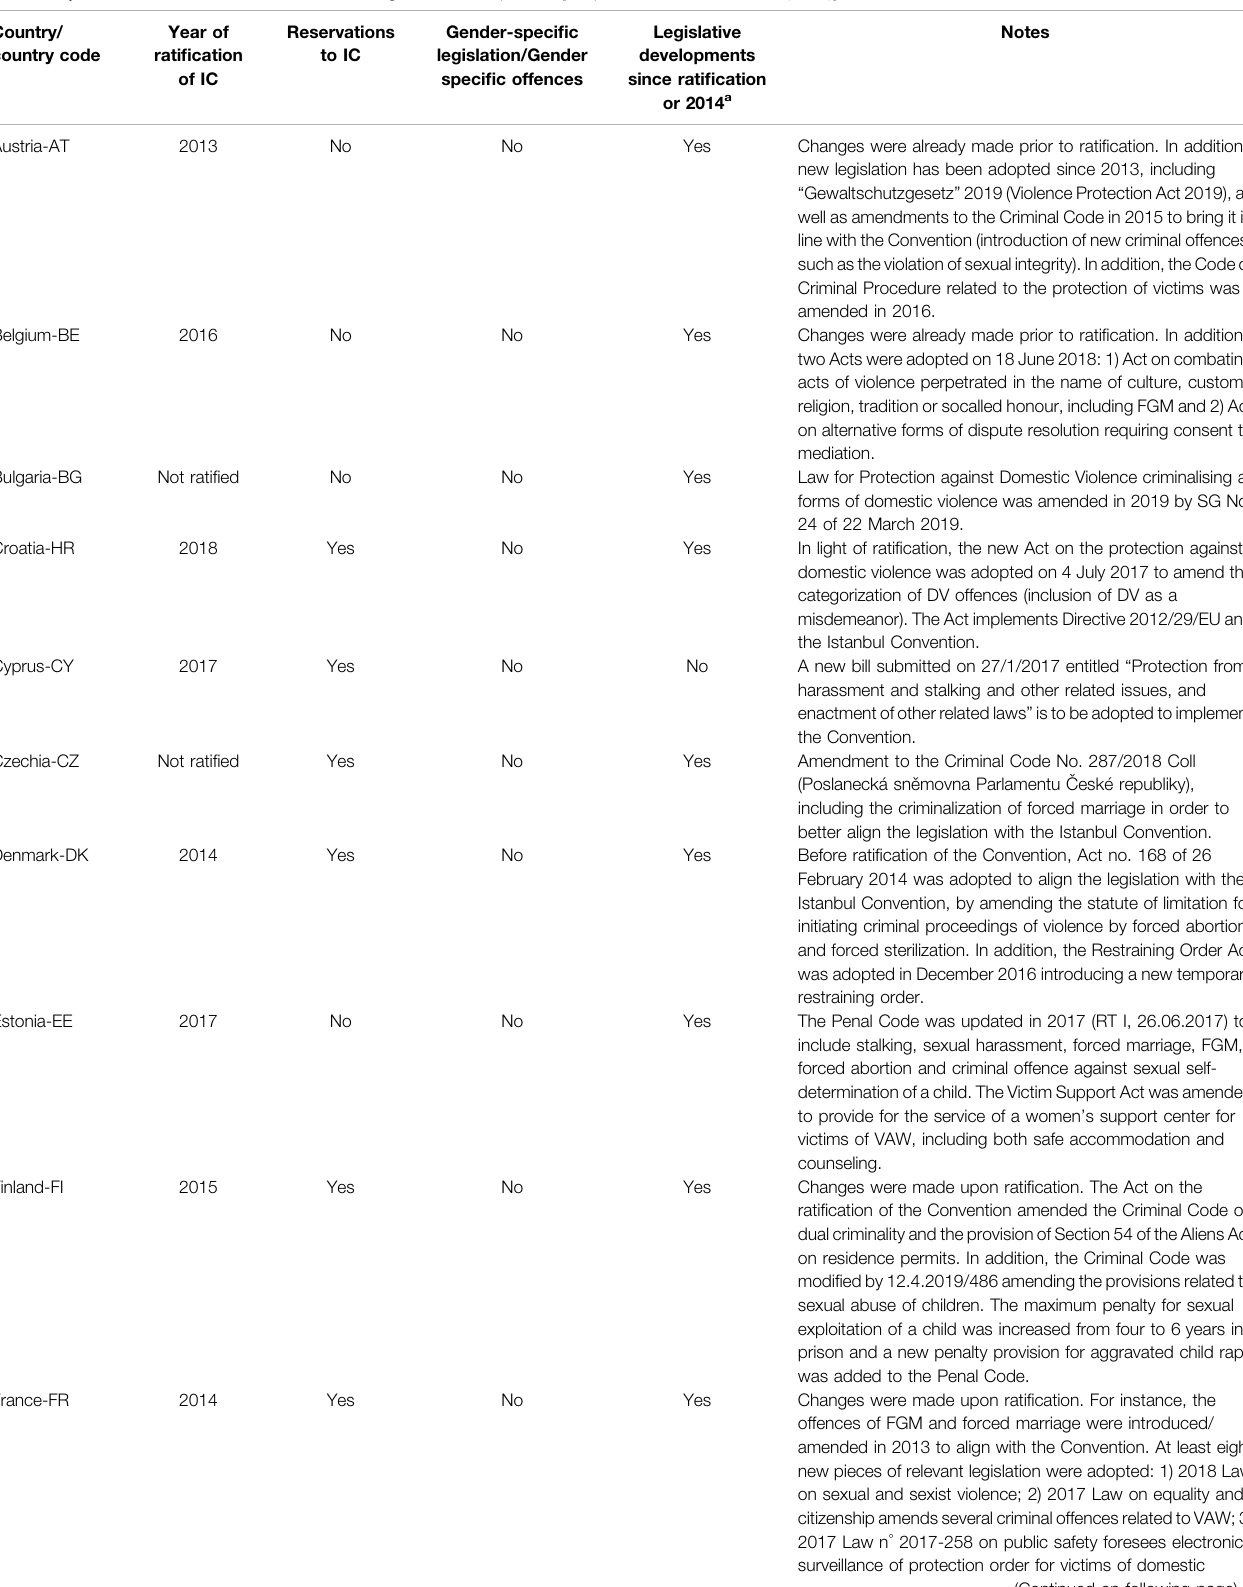
TABLE 1 | Overview rati fi cations, reservations and legislative developments [adapted from Meurens et al. (2020)]. Country/ country